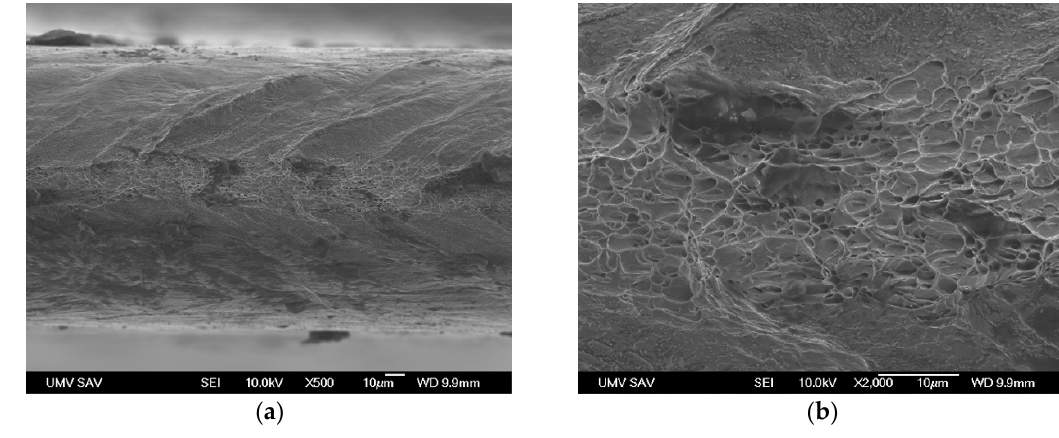
Figure 11. Fracture of material in the area of inclusion presence: ( a ) considerable contraction in the area of fracture; ( b ) defects observed in the area of fracture.